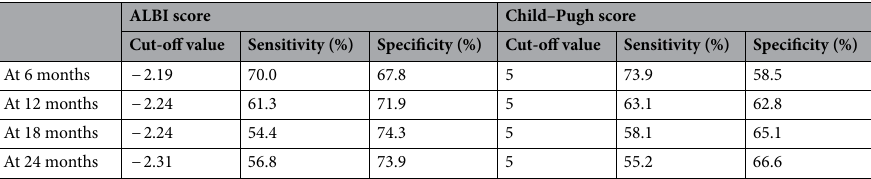
Table 3. Sensitivity, specificity, and cut-off values based on time-dependent ROC analysis. ROC Receiver operating